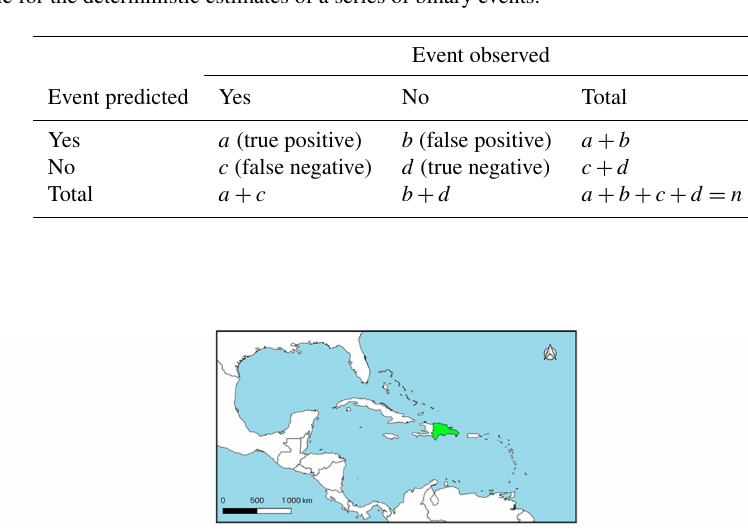
Table 4. Contingency table for the deterministic estimates of a series of binary events.